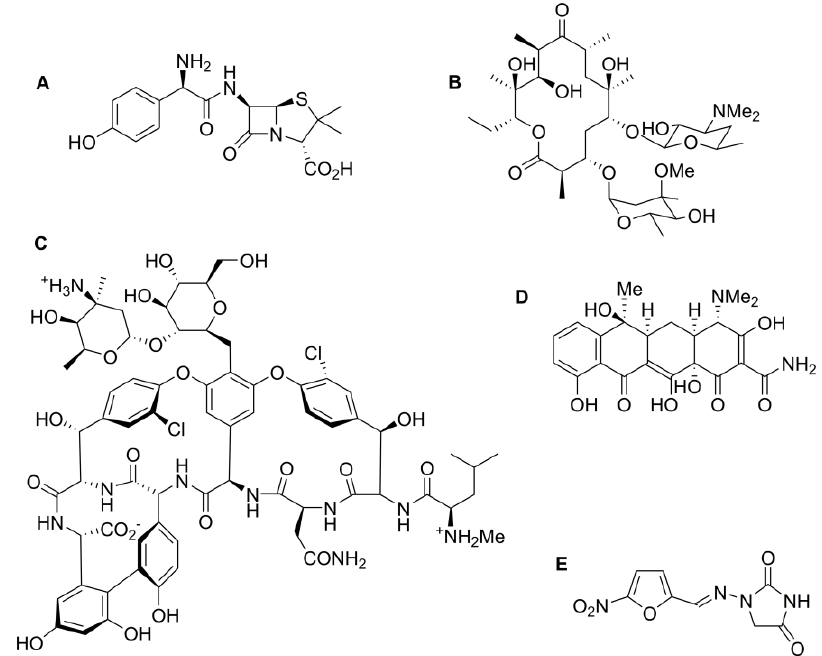
Figure 4. Chemical structures of ( A ) amoxicillin ； ( B ) erythromycin ； ( C ) vancomycin ； ( D ) tetracycline and ( E ) nitrofurantoin.